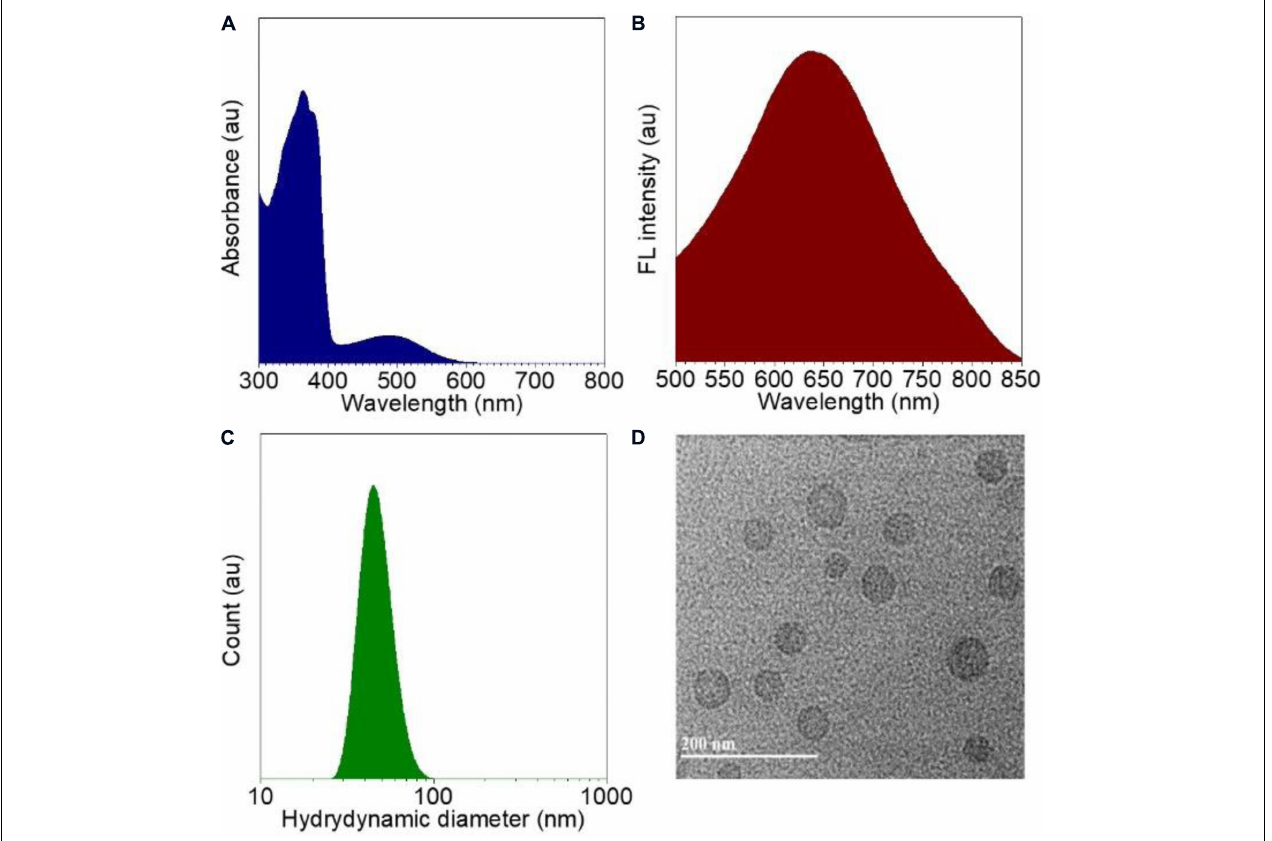
FIGURE 1 | Characterizations of CPPG AIE dots. (A) Absorption spectra recorded for CPPG AIE dots. (B) Fluorescence emission spectra for CPPG AIE dots. (C) Hydrodynamic diameter distribution obtained for CPPG AIE dots. (D) TEM image obtained for CPPG AIE dots. Synthesis route of small molecular drug amphiphile